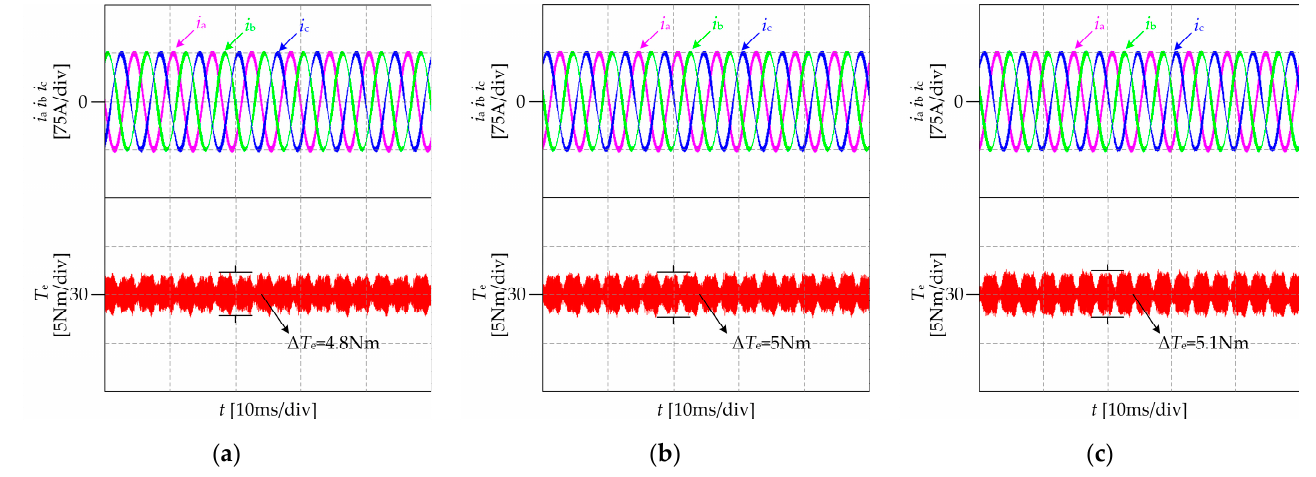
Figure 11. Simulation results of the capacitor value variation at 2500 r/min and 30 Nm: ( a ) 2000 μ F, ( b ) 1500 μ F, and ( c ) 1000 μ F.